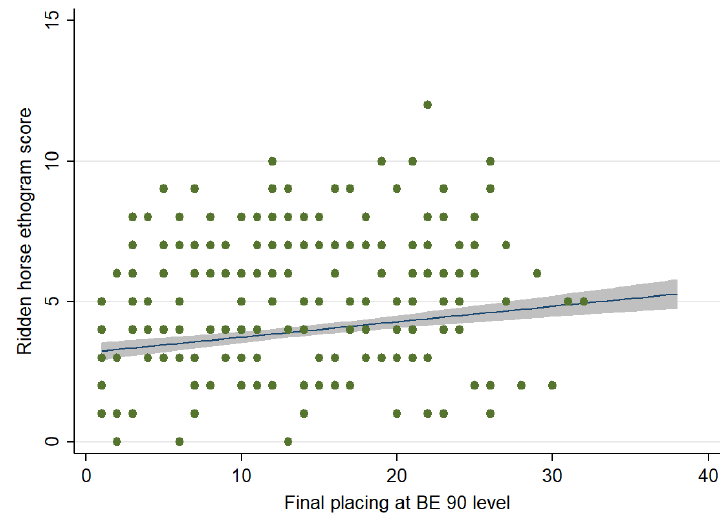
Figure 3. Relationship between the Ridden Horse Pain Ethogram (RHpE) scores and final placings at British Eventing 90 level. The green dots represent individual data points, the blue line is the best linear predicted fit and the grey area represents the corresponding 95% confidence interval. There was a weak positive correlation (rho= 0.157, p = 0.033) between the RHpE scores and final placings for 182 completions.